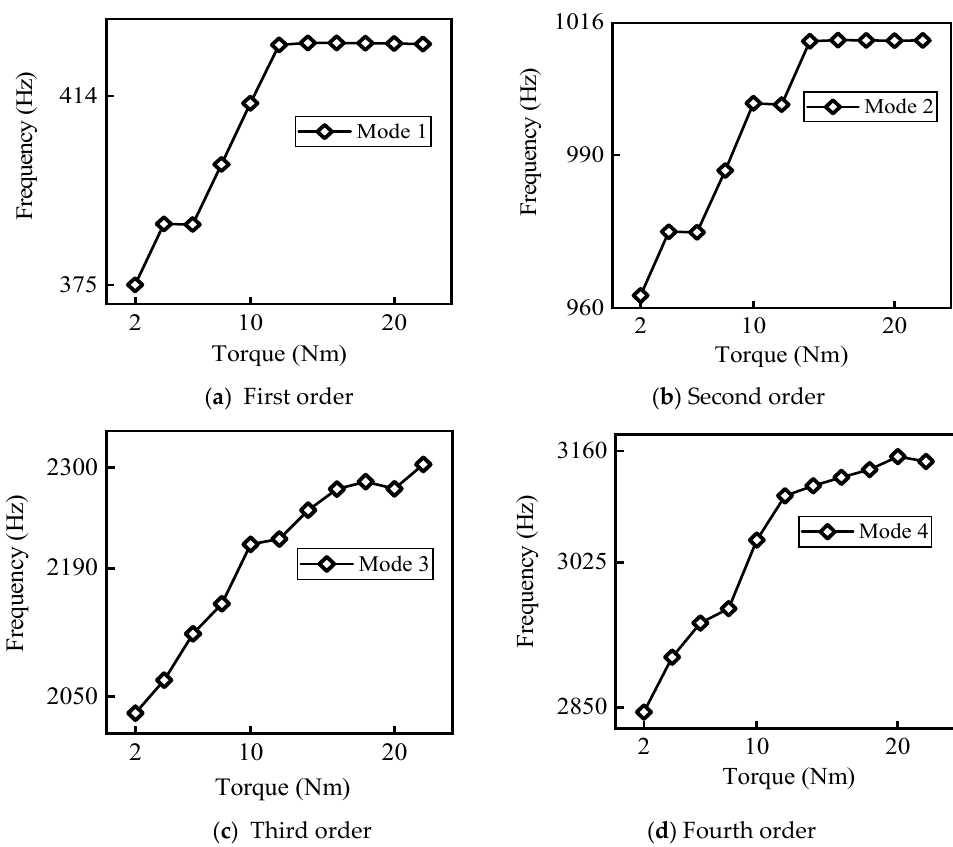
Figure 7. The relationship between the experimental frequency and the pre-tightening torque.